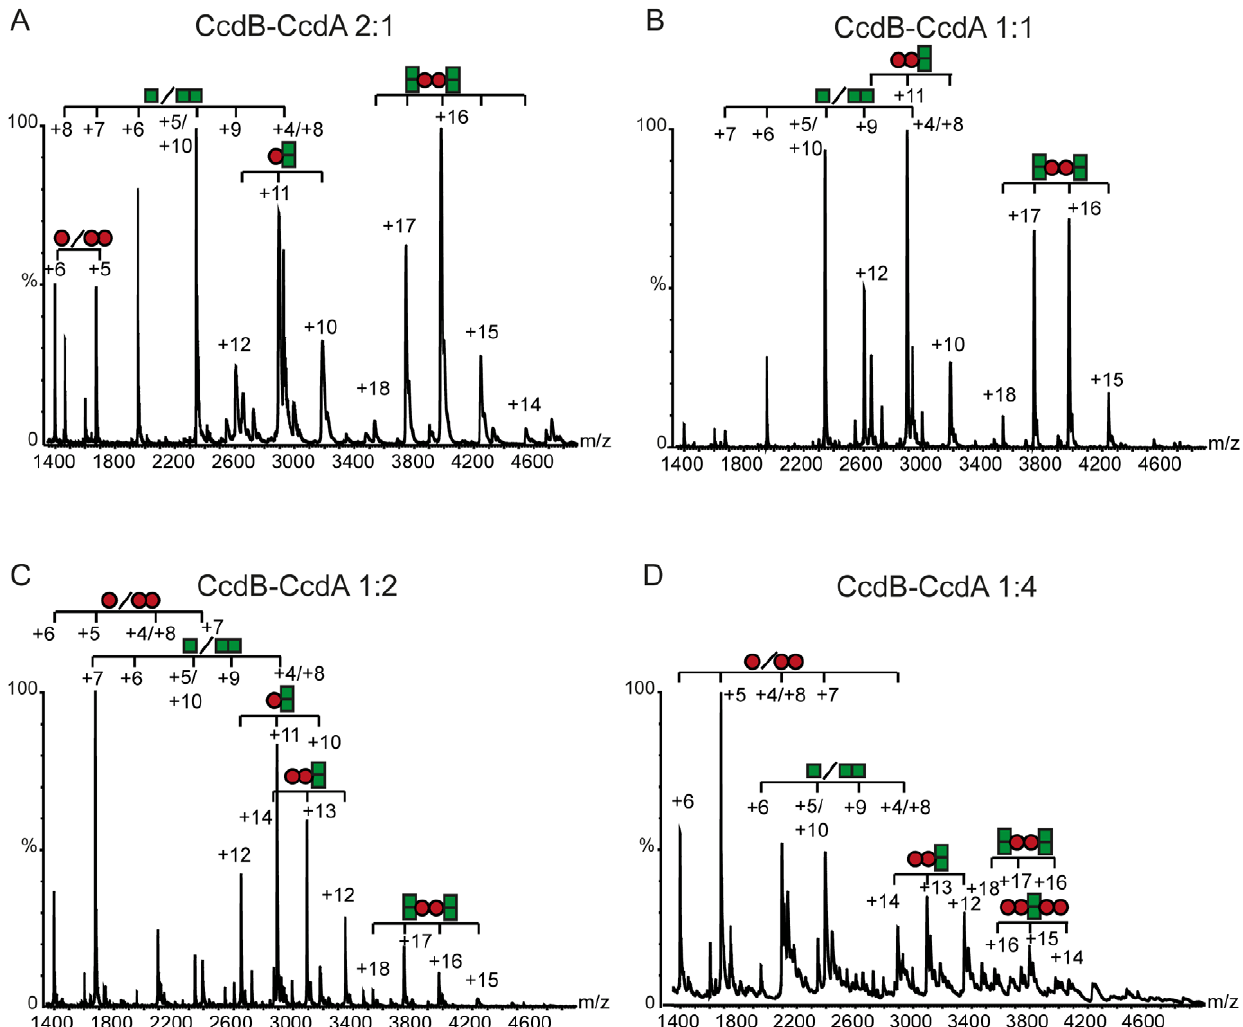
Figure 5. NMS profile of the interactions of CcdB and CcdA proteins at different toxin-antitoxin ratios. (A) Mass spectrum obtained at a CcdB:CcdA molar ratio of 2:1. (B) Mass spectrum obtained at a CcdB:CcdA molar ratio of 1:1. (C) Mass spectrum obtained at a CcdB:CcdA molar ratio of 1:2. (D) Mass spectrum obtained at a CcdB:CcdA molar ratio of 1:4. The lowest concentration of protein used was 10 m M. Mixtures of proteins were performed in 100 mM ammonium acetate pH 6.7. CcdB protein is represented with a green square, while CcdA protein is represented with maroon circles. Each complex found is represented with the appropriate combination of squares and circles.